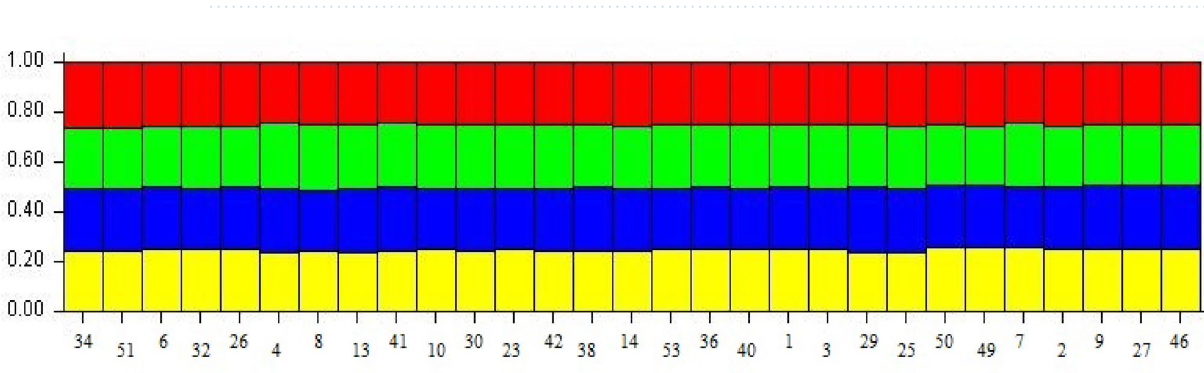
Figure 3. Line plots from the mix model of Ln P(D) and ∆K structure for squash populations ( a ) The average value of the Ln P(D) statistic produced by the structure at each value of K, ( b ) DK.